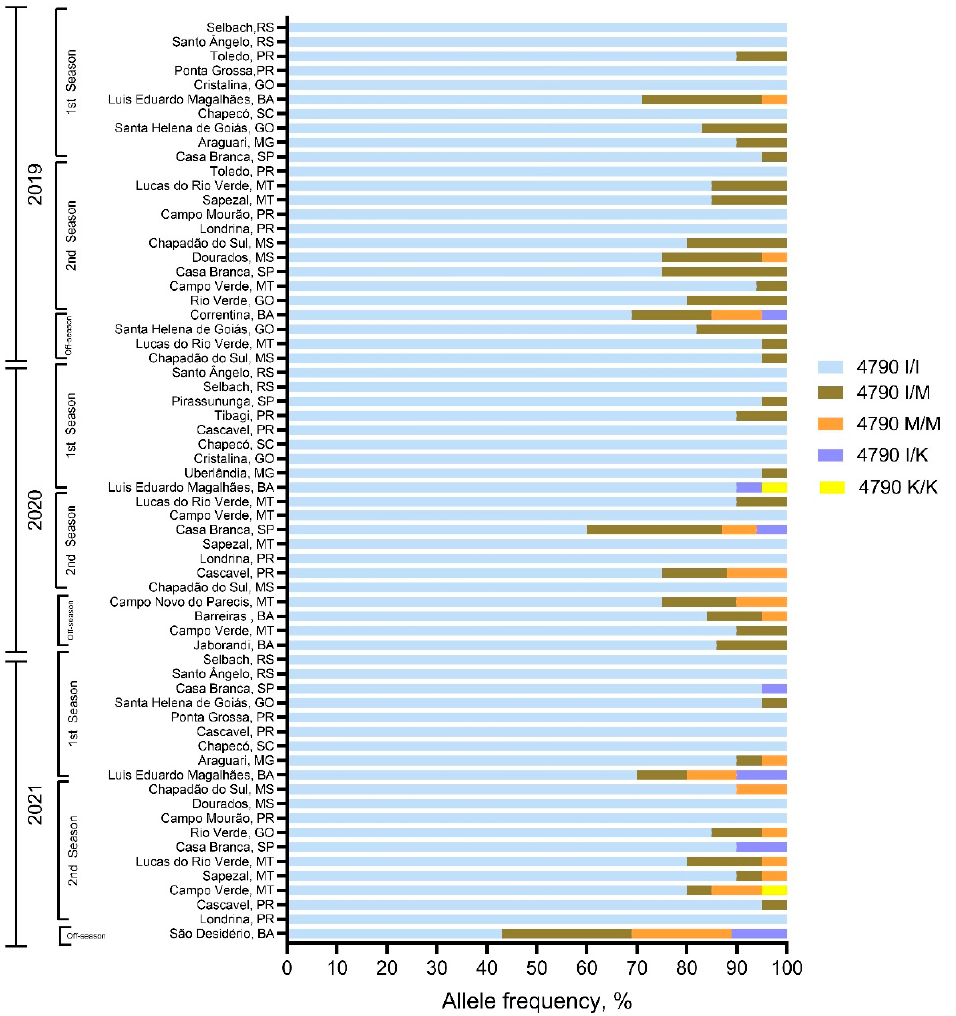
Figure 4. Genotyping of diamide resistance allele frequency in Brazilian populations of Spodoptera frugiperda . Homozygous and heterozygous ryanodine receptor (RyR) allele frequencies in field-collected fall armyworm samples. Samples were analyzed employing a PCR-based allelic discrimination assay for the presence of RyR resistance alleles I4790 (wildtype), M4790 and K4790 (resistant) (numbering according to Plutella xylostella RyR, GenBank JN801028). For a detailed data table depicting the number of analyzed individuals per location, please refer to the Supplementary Materials (Table S4).